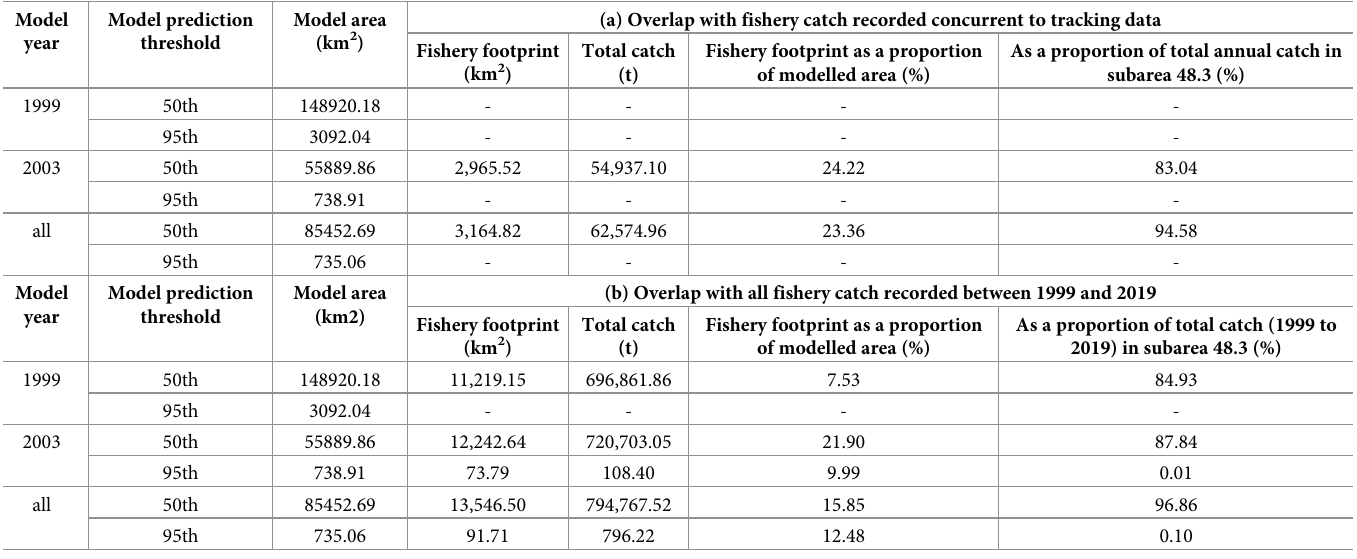
Table 3. Spatial overlap of the krill fishery and model predictions of the likelihood of occurrence of female fur seals during the winter months (May to September, inclusively) at two threshold levels; > 95% likelihood, and > 50% likelihood of